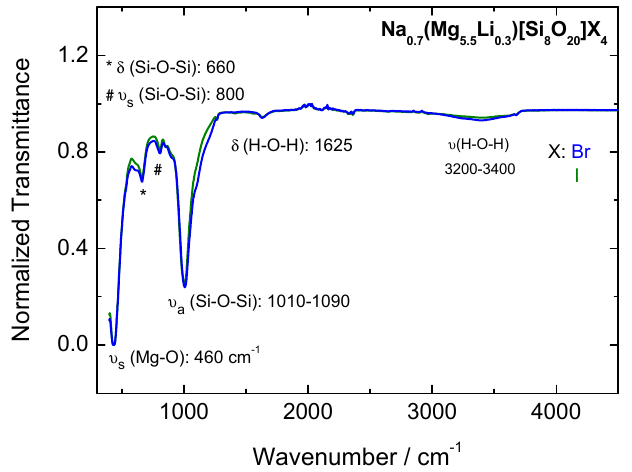
Figure 3. The FTIR spectra of the bromohectorite and iodohectorite.